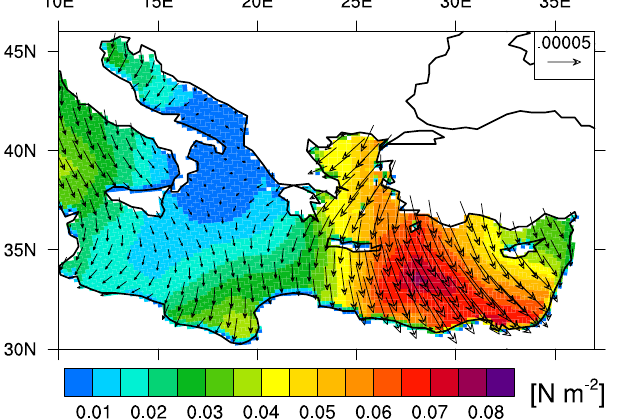
Fig. 15. Temperature change through vertical advection averaged between 12 and 42m of depth (colours) and vertical velocities (fill patterns, positive values for upward velocities) in July for